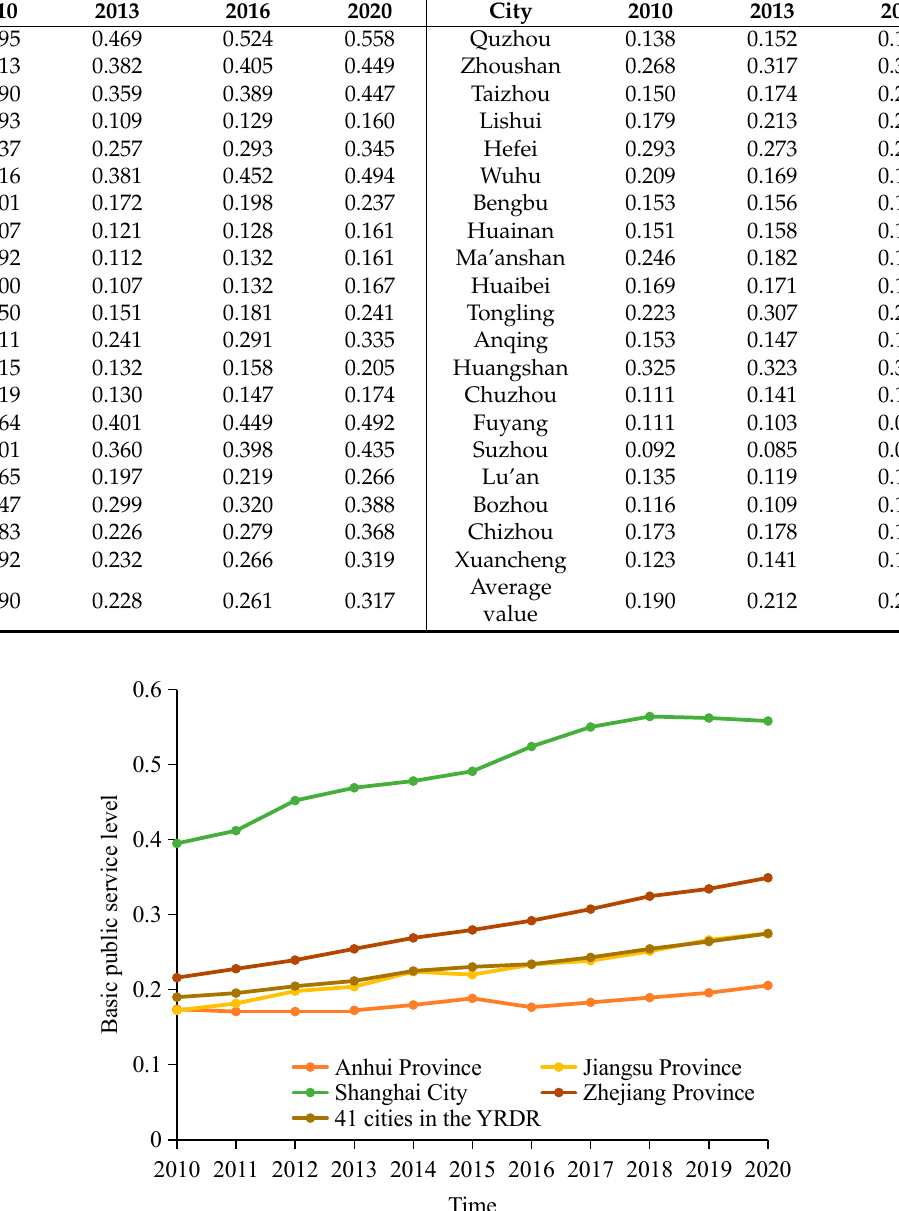
Figure 2. Changes of the BPSL in the Yangtze River Delta provinces and cities, 2010–2020.